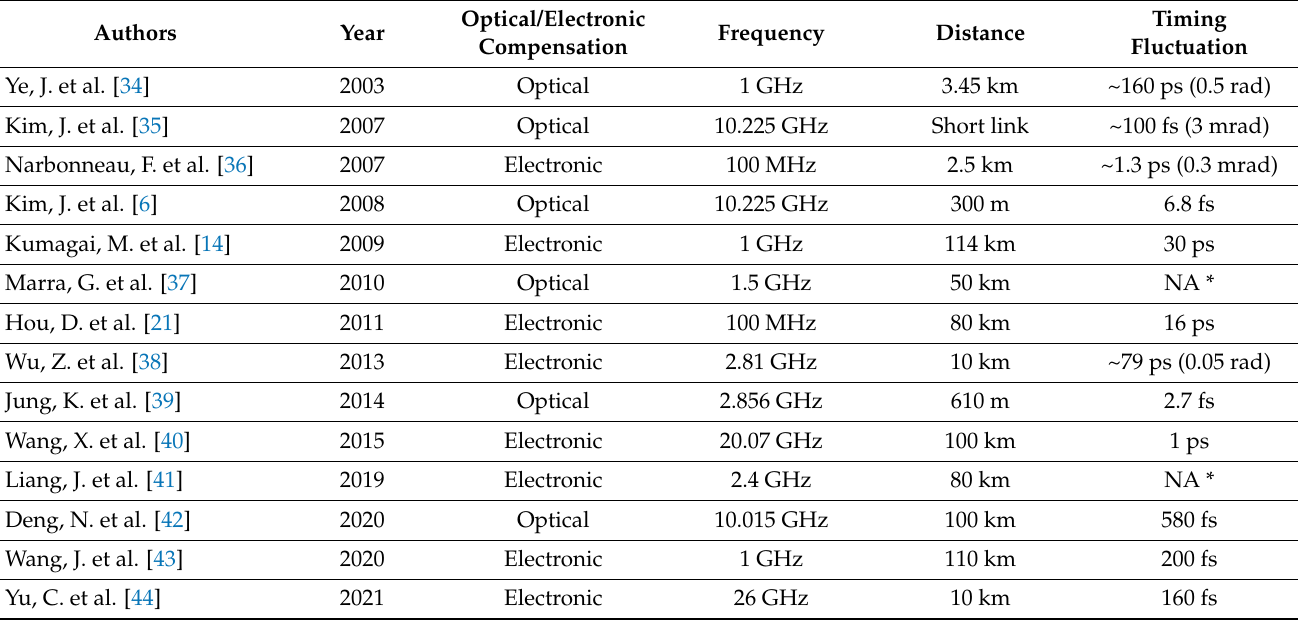
Table 1. Comparison of different experiments of fiber-based RF